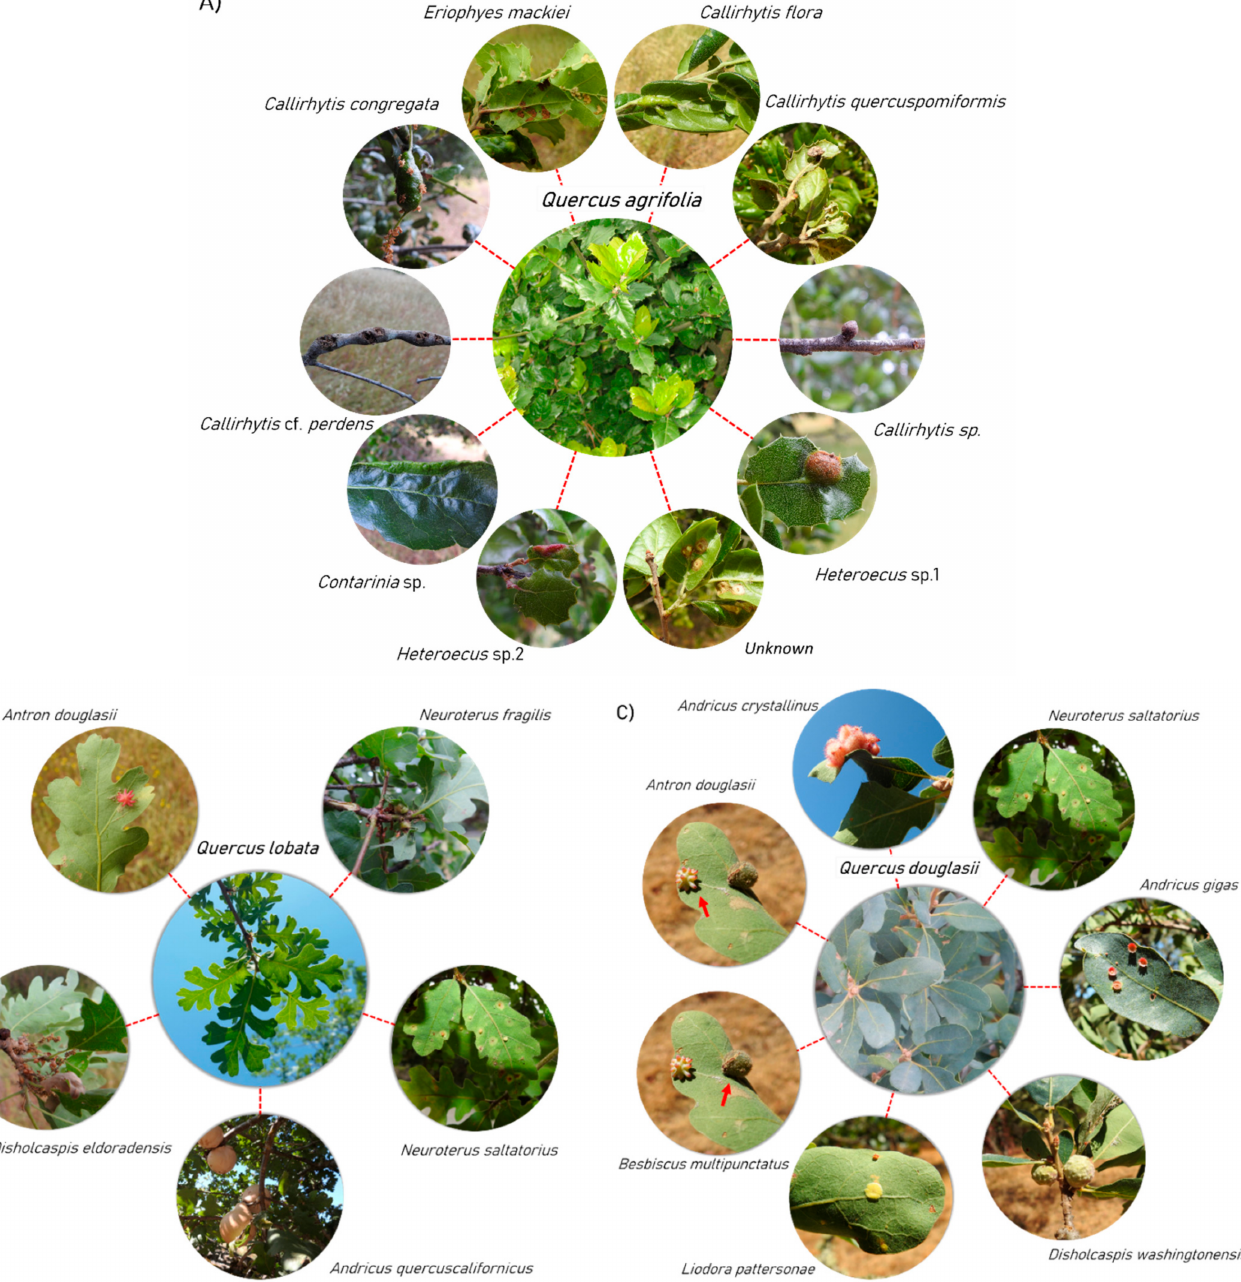
Figure 3. Oak galls on Quercus agrifolia ( A ), Q. lobata ( B ) and Q. douglasii ( C ) at Jasper Ridge Biological Preserve, Northern California,